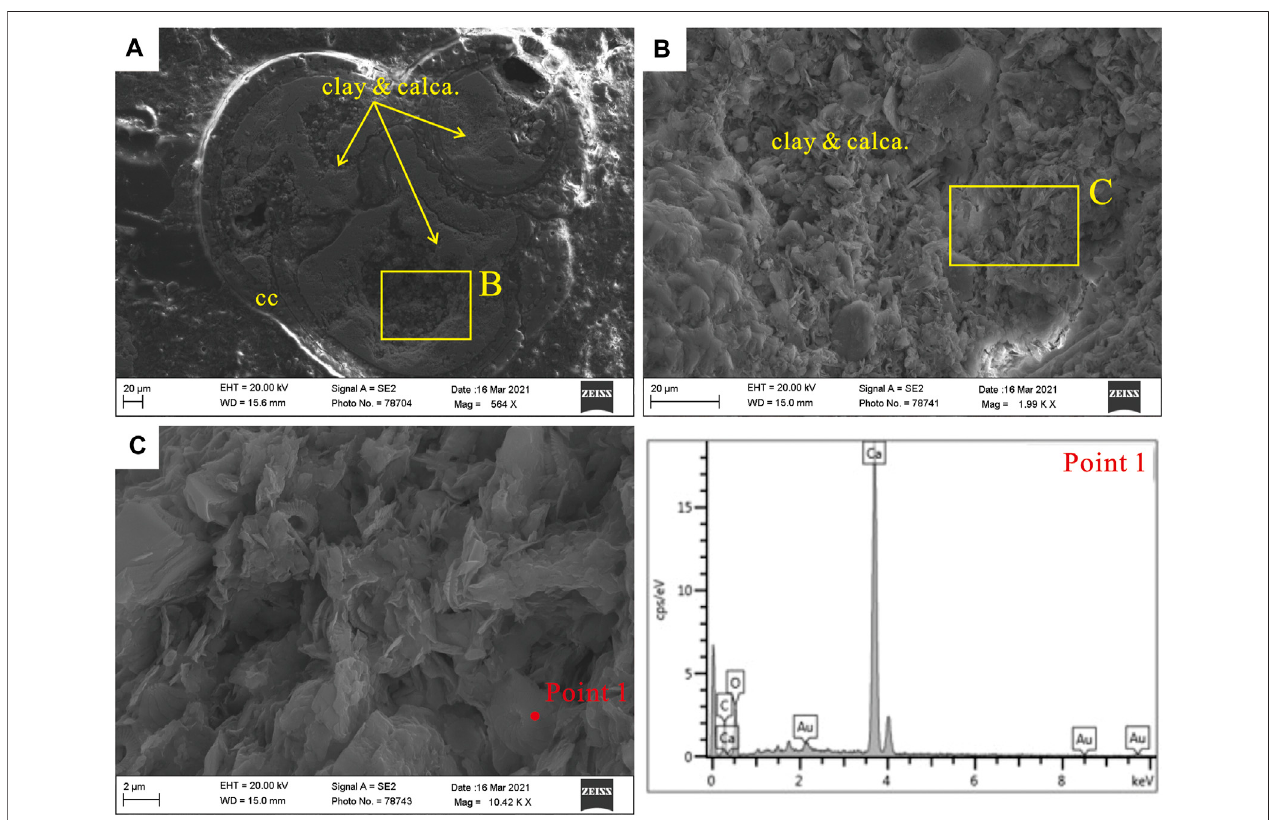
FIGURE 10 | Calcareous ultra-microfossils and clay minerals fi ll foraminifera coeloms. (A) Site W19, 126.60 mbsf, SEM image; (B) enlarge the yellow box in fi gure (A) ; (C) enlarge the yellow box in fi gure (B) ; cc and calca. are short for calcite and calcareous ultra-microfossils, respectively.